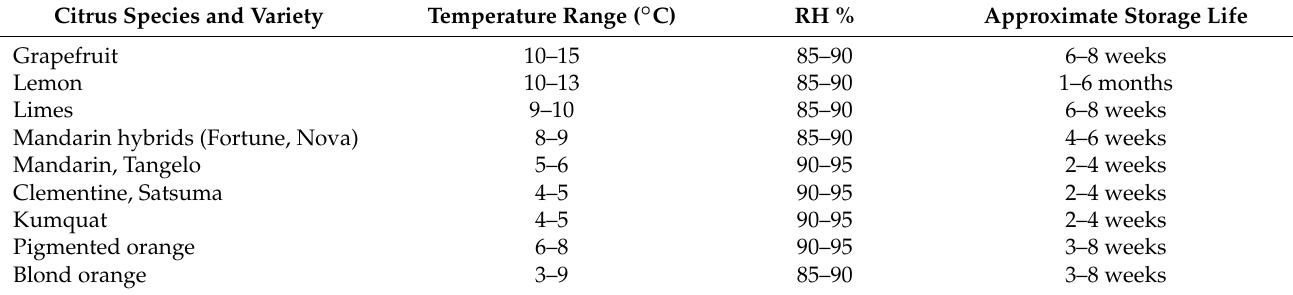
Table 1. Recommended temperature ranges, relative humidity (RH) values and approximate storage lives for citrus fruit